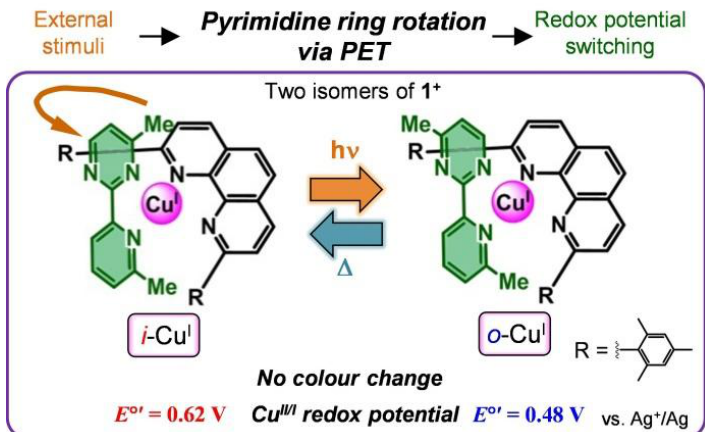
Figure 3. Schematic illustration of the photo-driven ring rotation of the pyrimidine moiety, and the accompanying change in the redox potential of the Cu II /Cu I couple in 1  BF Adapted with permission from [42]. Copyright (2012) American Chemical Society.